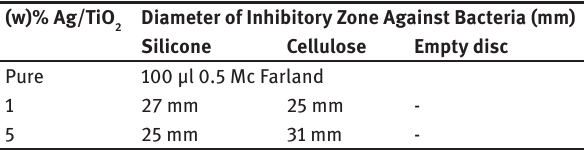
Figure 4: Image of the zones showing Inhibitory Effect of Ag /TiO Nanofibers against S. Aureus. Table 2 : Diameter of Inhibitory Zone against